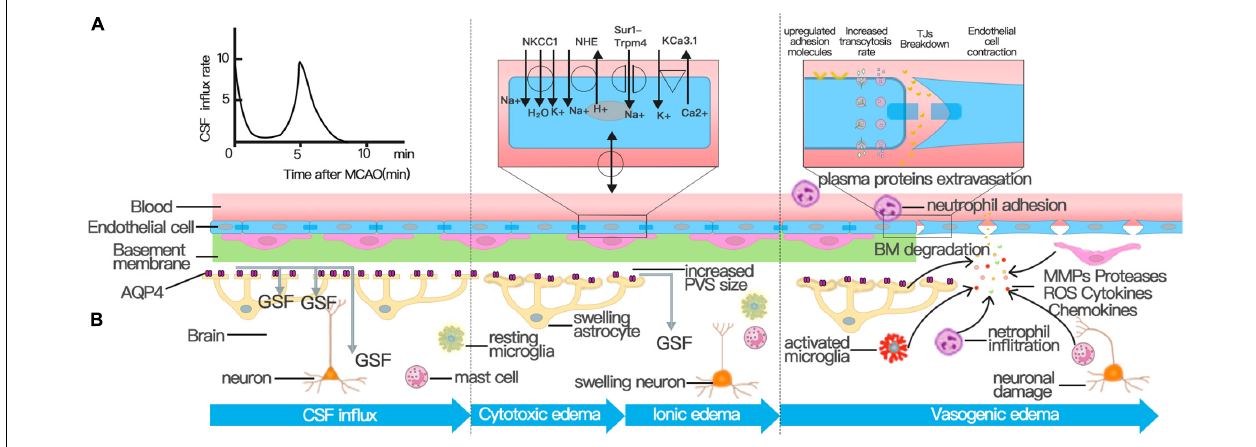
FIGURE 2 | Three distinct phases of cerebral edema. (A) CSF influx occurred and peaked at 11.4 ± 1.8 s and 5.24 ± 0.48 min after MCAO. The first peak of CSF influx is the hydrostatic pressure gradient due to vascular obstruction. The increased PVS size triggered by spreading depolarizations (SDs) drives the second wave of perivascular CSF influx, which facilitates the swelling of astrocytic endfeet. (B) Cerebral edema can be classified into three phases: cytotoxic, ionic, and vasogenic edema phases. The cytotoxic edema phase is characterized by swelling of astrocytes and happens simultaneously with the second peak of CSF entry. The second stage of cerebral edema formation, the ionic edema stage, is mainly driven by endothelial ion channels and transporters in the context of an intact BBB, such as NKCC, NHE, KCa3.1, and Sur1-Trpm4 channel. The breakdown of BBB causes vasogenic edema. Successive alterations to the transcellular and paracellular pathway of the BBB contribute to the breakdown of BBB following stroke. First, the increase in the number of endothelial caveolae and the rate of transcytosis impairs BBB function by disturbing the transcellular pathway. Then the destruction of TJs activates the paracellular pathway. In addition to NVU cells involved in the regulation of BBB permeability, various immune cells and inflammatory factors play an important role in the destruction of